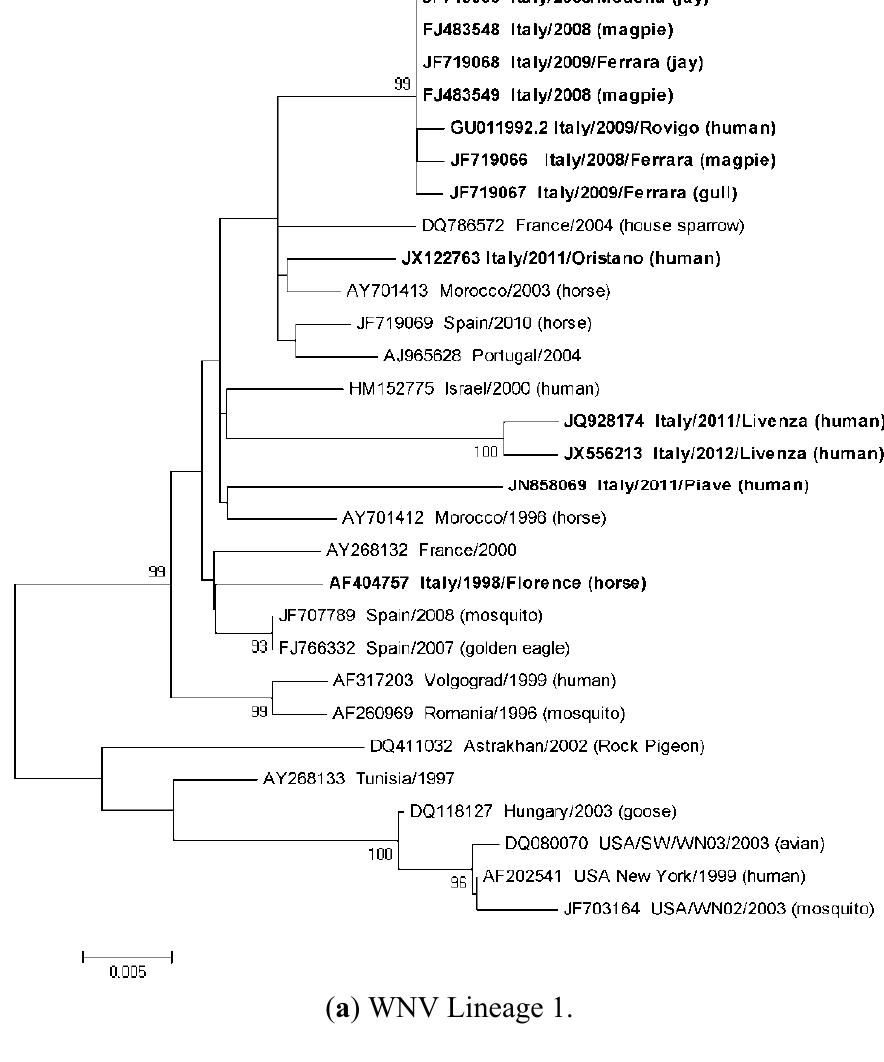
Figure 3. Molecular phylogenetic analysis by Maximum Likelihood method of Italian WNV strains. The evolutionary history was inferred by using the Maximum Likelihood method based on the Tamura-Nei model [83]. The percentage of trees in which the associated taxa clustered together is shown next to the branches. Initial trees for the heuristic search were obtained by applying the Neighbor-Joining method to a matrix of pairwise distances estimated using the Maximum Composite Likelihood (MCL) approach. The trees are drawn to scale, with branch lengths measured in the number of substitutions per site. All positions containing gaps and missing data were eliminated. Evolutionary analyses were conducted in MEGA5 [84]. GenBank accession numbers of the sequences are indicated near the name of WNV strain. Italian WNV sequences are highlighted in bold.